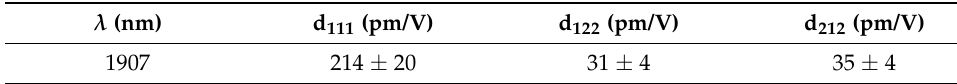
Table 13. NLO coefficients of DSTMS